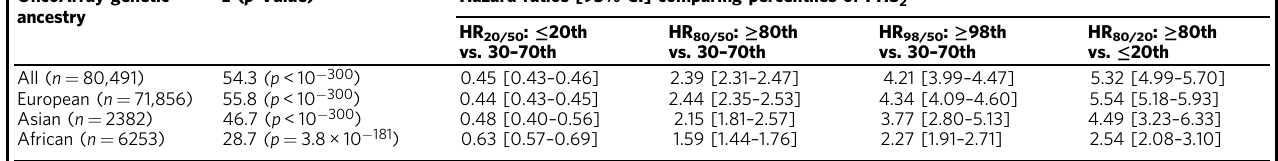
Table 1 Association of PHS with prostate